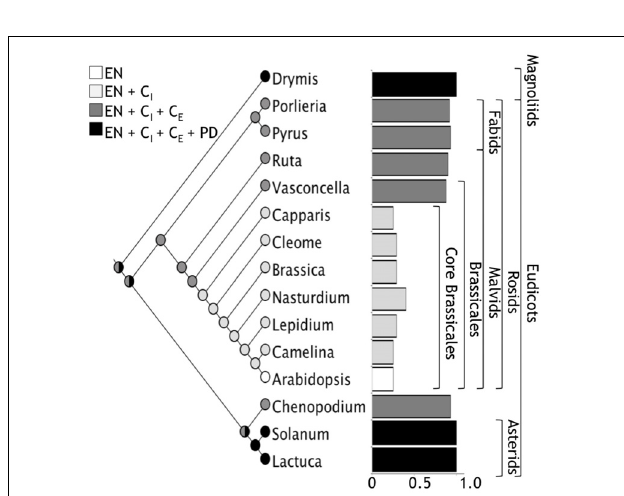
FIGURE 7 | A global view of iron distribution in embryos. Phylogenetic tree showing all the species analyzed in this study. Colors of circles indicate type of cells that accumulate iron in the hypocotyl. White, only endodermis; light gray, endodermis + internal cortex (C I ); dark gray, endodermis + internal cortex + external cortex (C E ); black, endodermis + internal cortex + external cortex + protodermis (PD). Cortex cell are defined as the cell layers that are between the endodermis and the protodermis, we refer as internal cortex the cell layers than are near to the endodermis. Ratio of number of cells where iron is accumulated versus total number of cell layers from the endodermis to the protodermis for embryos from different orders are indicated in bars. Colors of bars correspond to the same code described